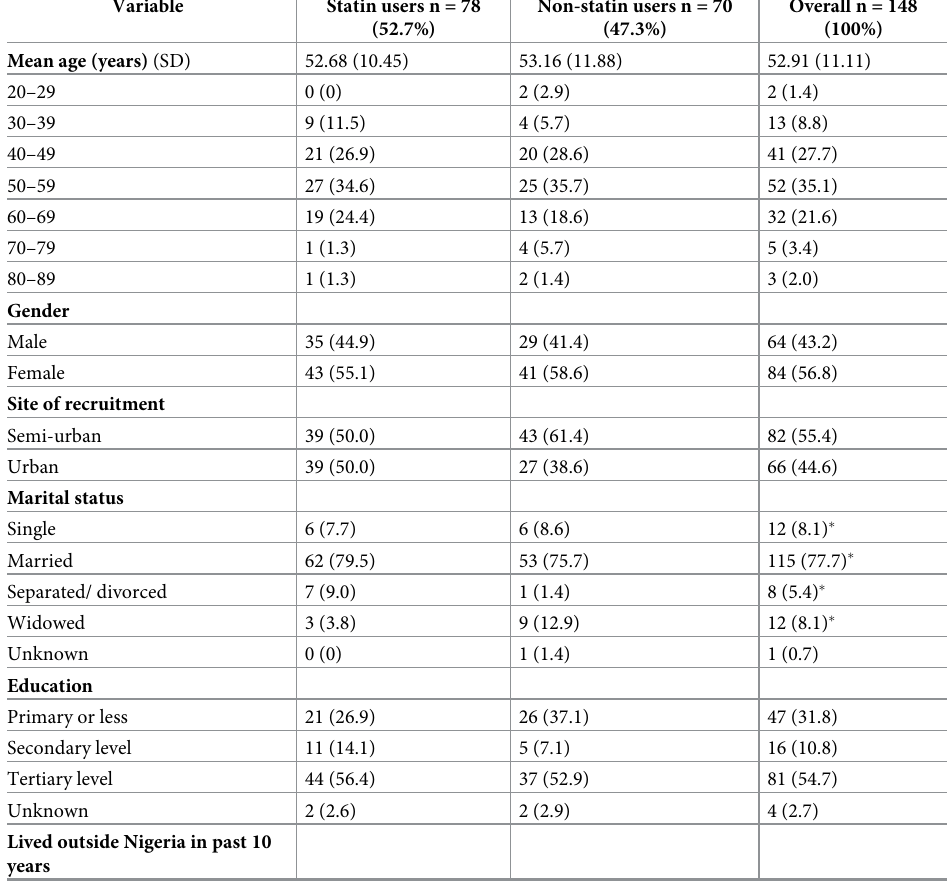
Table 1. Characteristics of quantitative study